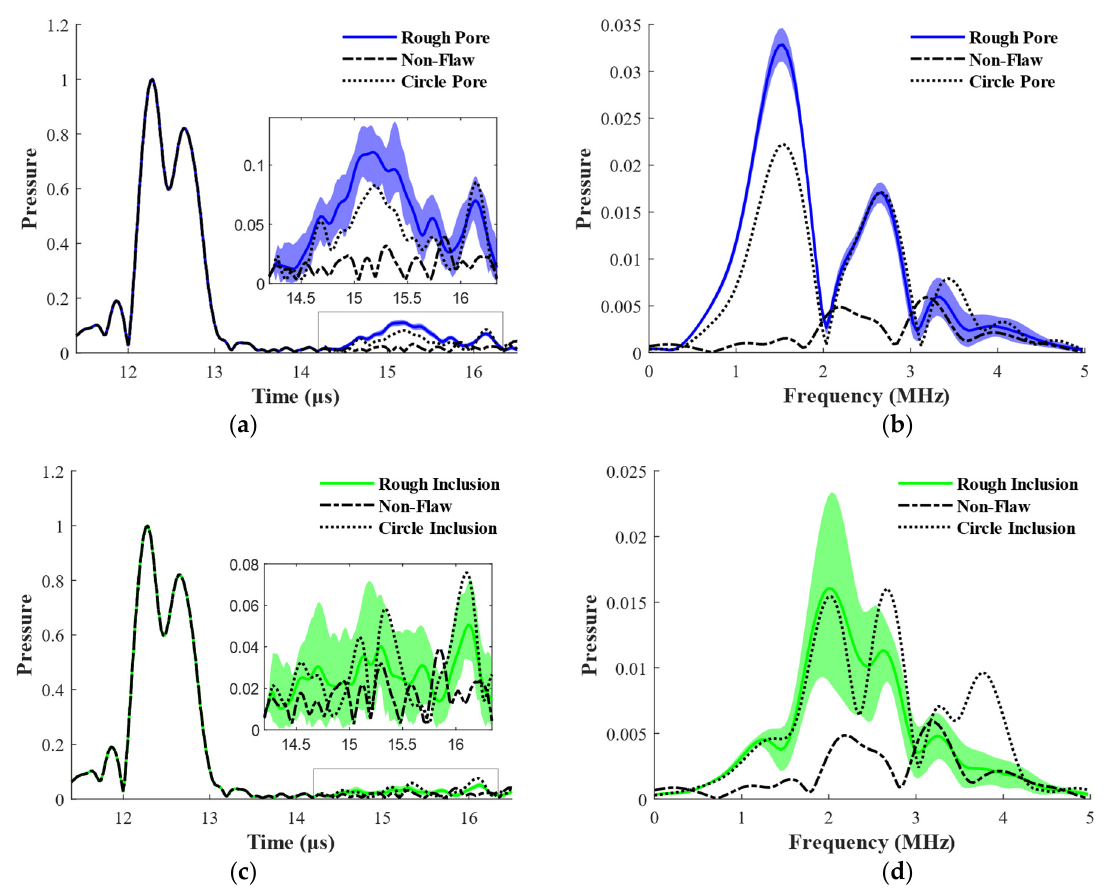
Figure 11. Statistical results for the rough pore and rough inclusion. ( a ) Rough pore, time domain; ( b ) rough pore, frequency domain; ( c ) rough inclusion, time domain; ( d ) rough inclusion, frequency domain.